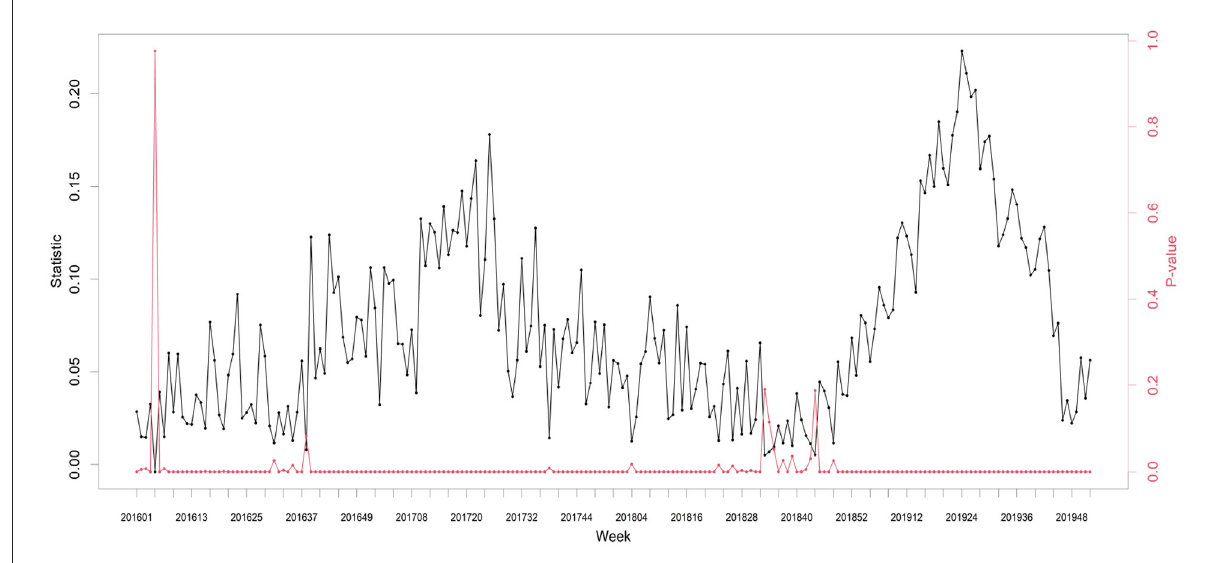
FIGURE3 Time series plot of weekly Moran’s I and its P-value from 2016 to